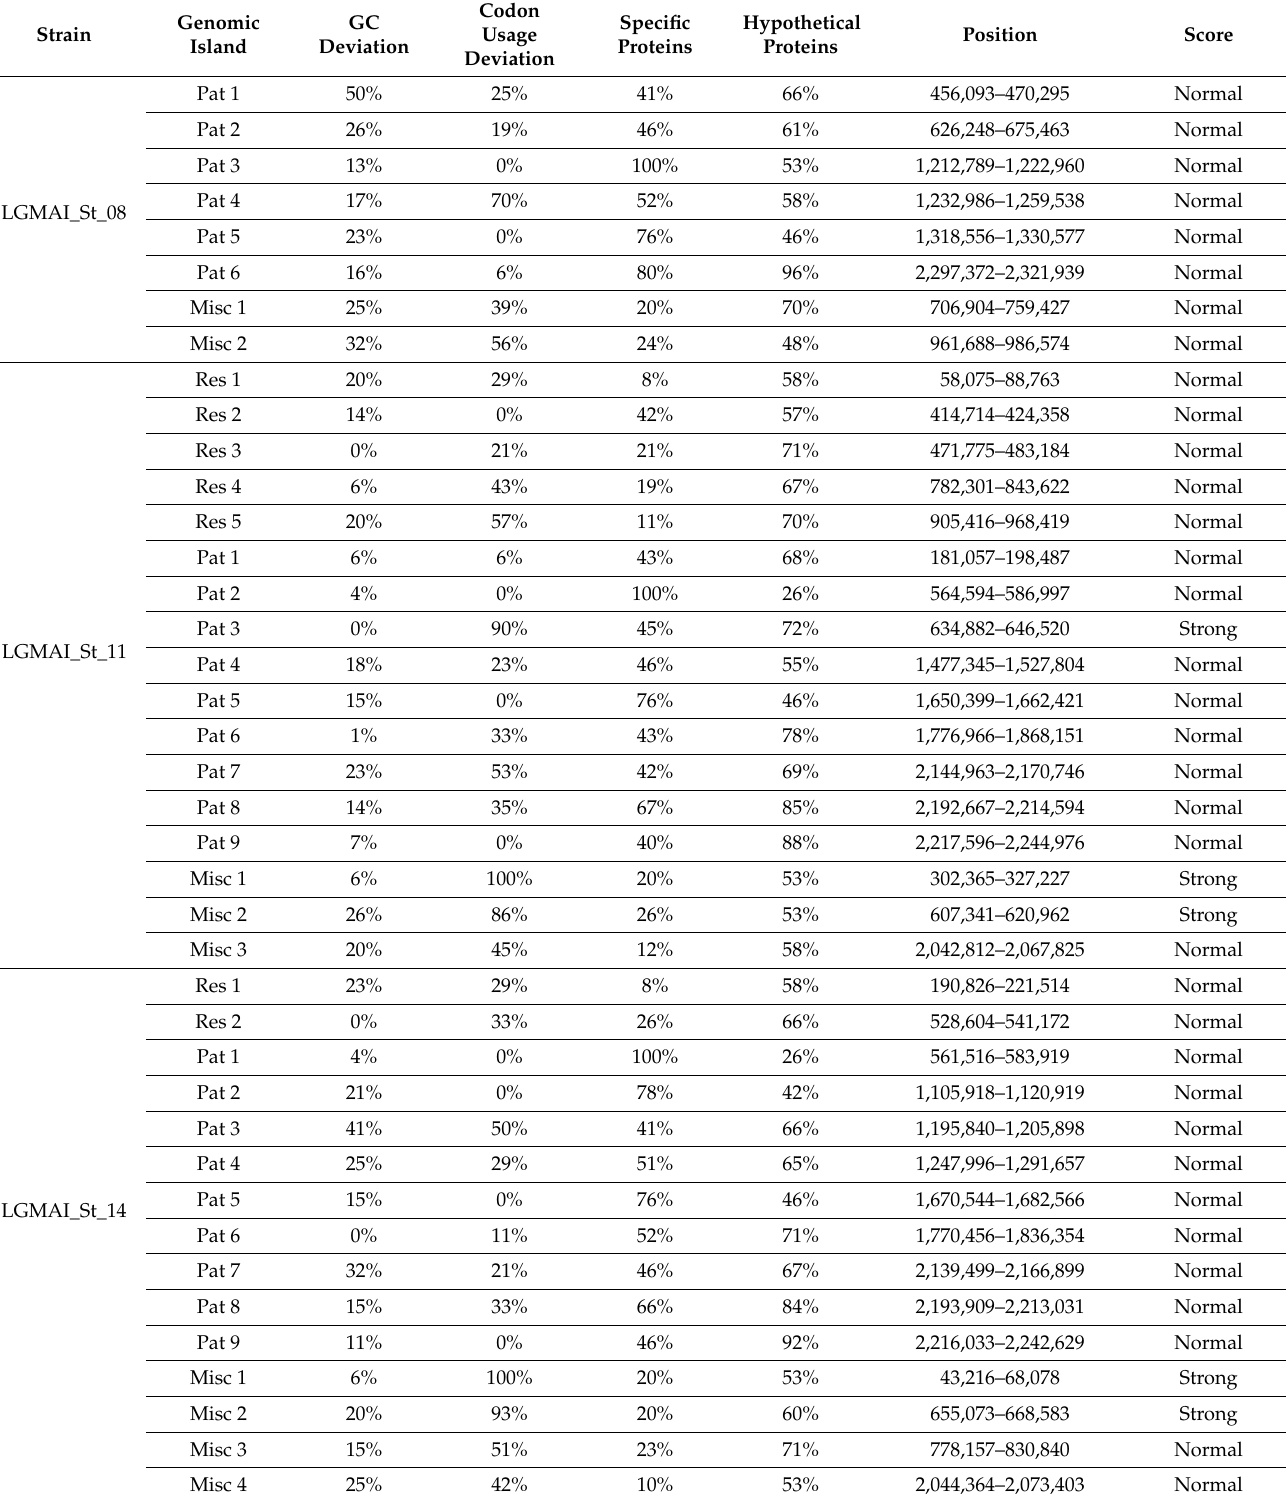
Table 9. Extract from complete genomic island prediction results depicting only the predicted genomic islands with scores strong and normal. Res: resistance island; Pat: pathogenicity island; Misc: miscellaneous